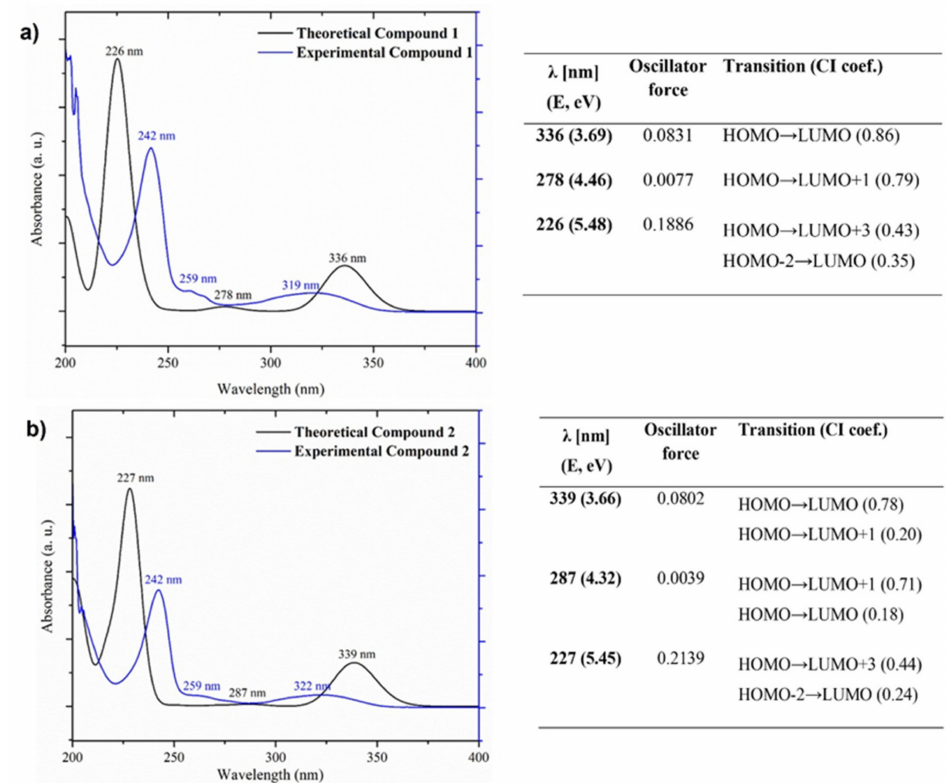
Figure 10. ( a ) Experimental UV-Vis absorption spectra of ( a ) 1 and ( b ) 2 in ethanol solution (1.0 × 10 − 4 M, blue) and TD-DFT calculated transitions